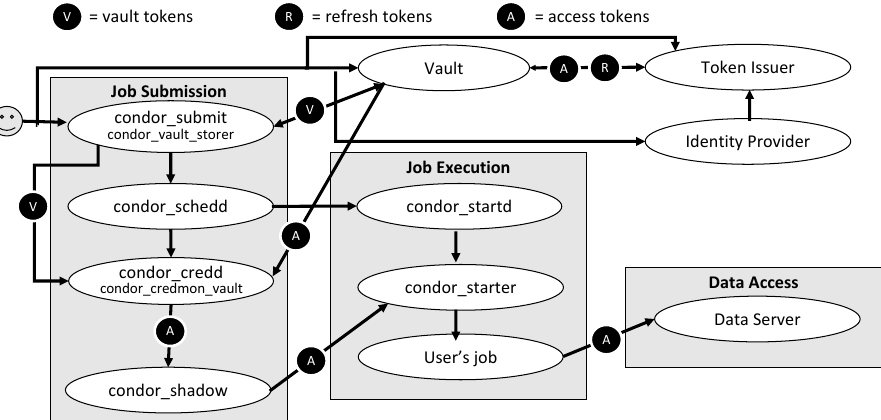
Figure 2. Vault integration components in a full HTCondor